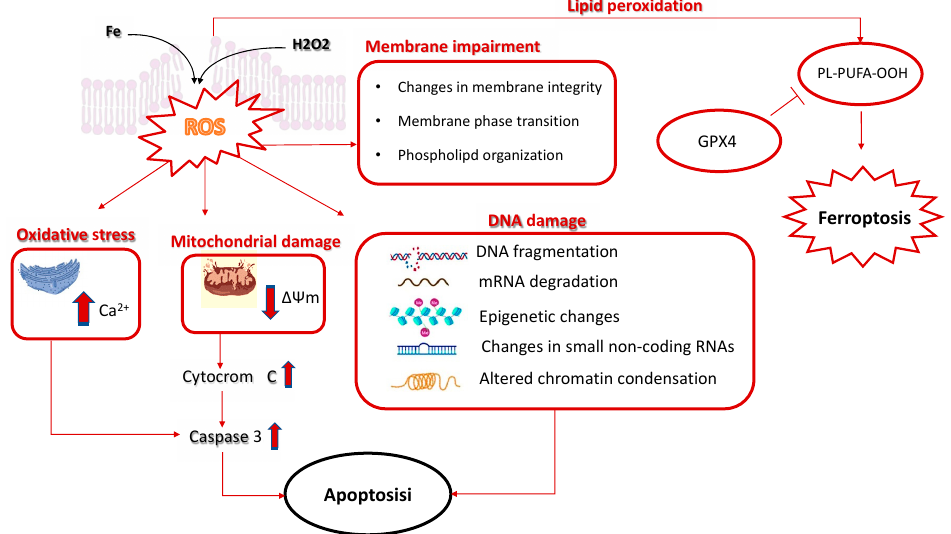
Figure 1. Membrane alterations caused by cryopreservation. The cryopreservation process can cause alterations of the cellular membrane and specific changes in phospholipid organization and bilayer integrity, as well as modifications of the membrane ultrastructure. The oxidative damage of membrane lipids caused by reactive oxygen species (ROS) overproduction is a key underlying event in cellular damage consequent to cryopreservation. An excess of free radicals can derive, for example, from the Fenton reaction or other cellular oxidative stress processes that ultimately sustain lipid peroxidation and membrane impairment. These include an excess of Ca2 + influx into the cytoplasm from the extracellular environment and from the endoplasmic reticulum. Moreover, oxidative stress induces a rapid depolarization of the inner mitochondrial membrane potential and subsequent impairment of oxidative phosphorylation, as well as the release of cytochrome c, which is a main trigger of the intrinsic pathway of apoptotic cell death. Membrane lipid peroxidation may lead to the formation of eicosanoids associated with ferroptotic signaling. Ferroptosis is an iron-dependent cell death program that is prevented by the activity of glutathione peroxidase 4 (GPx4) [16].